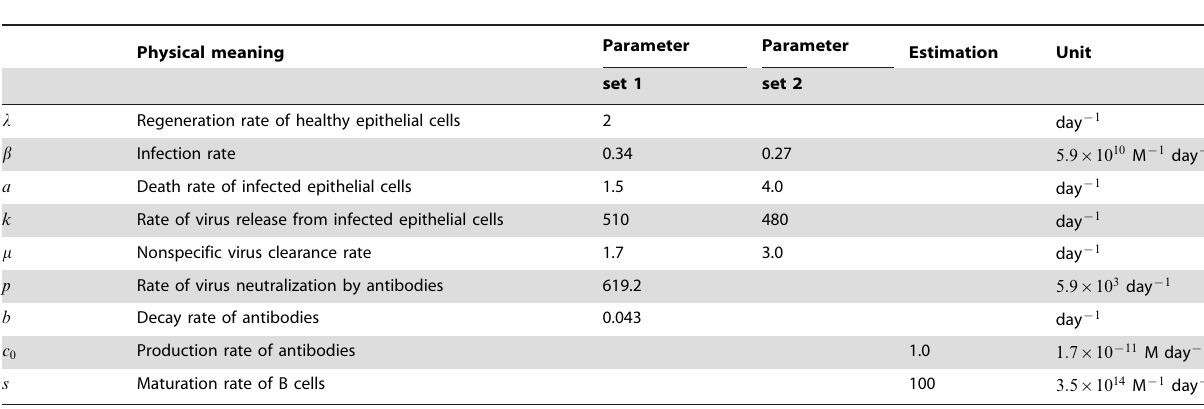
Table 2. Parameters of the dynamical